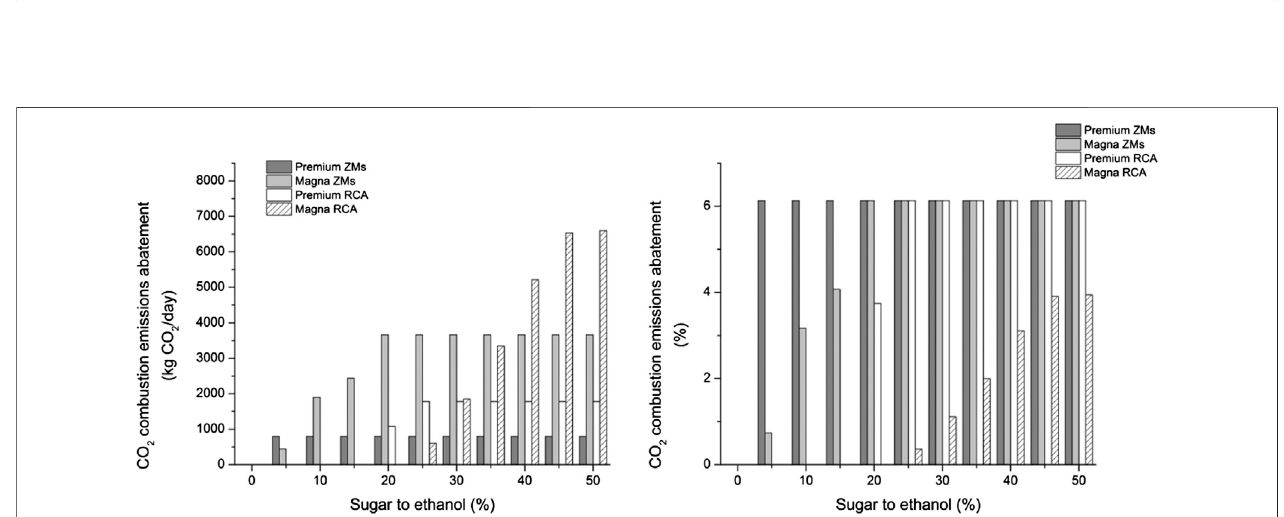
FIGURE 10 | CO 2 combustion emission abatement (left) and its percentage (right) by using ethanol as gasoline oxygenate agent.